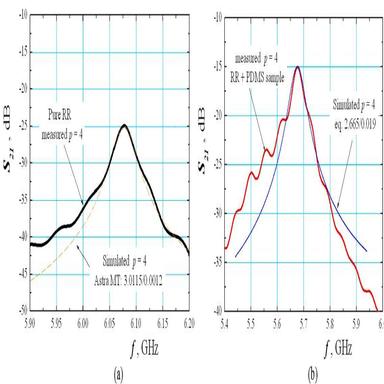
Measured and simulated resonance curves for TEM mode with p = 4 of microstrip ring resonator on substrate ISOLA Astra MT 3.0 without (a) and with (b) covering PDMS sample.